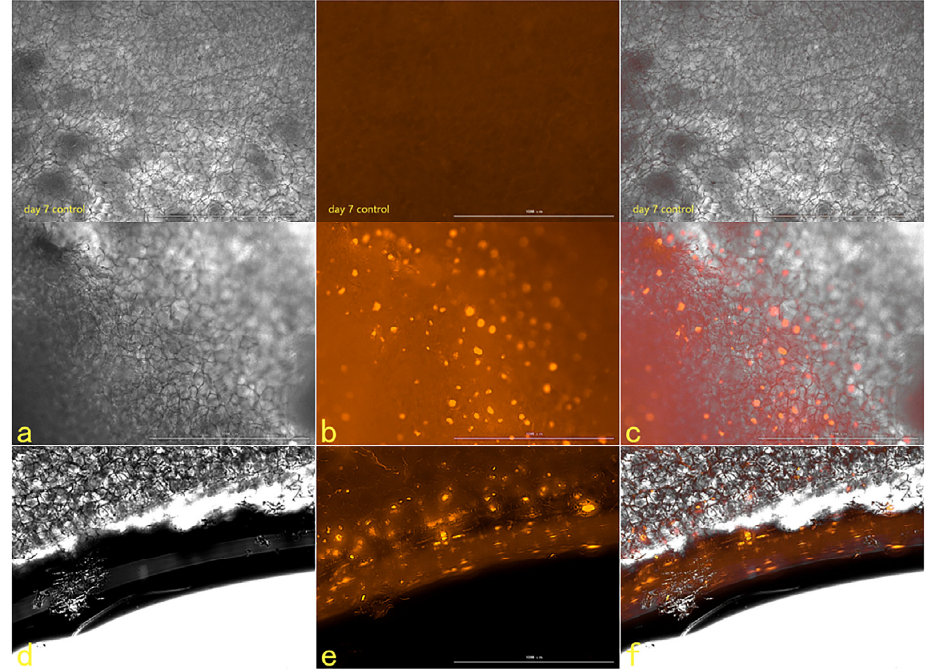
Figure 18. The HSFs detected on a three-dimensional scaffold, day 7. In the picture, ( a – c ) are the front of the stent, and ( d – f ) are the cross sections of the stent. ( a , d ) are bright fields, ( b , e ) are fluorescent fields, and ( c , f ) are composite pictures of bright fields and fluorescent fields. Control: only cell scaffolds and a culture medium containing AGQDs, no HSFs. Scale bars: 1000 μ m.